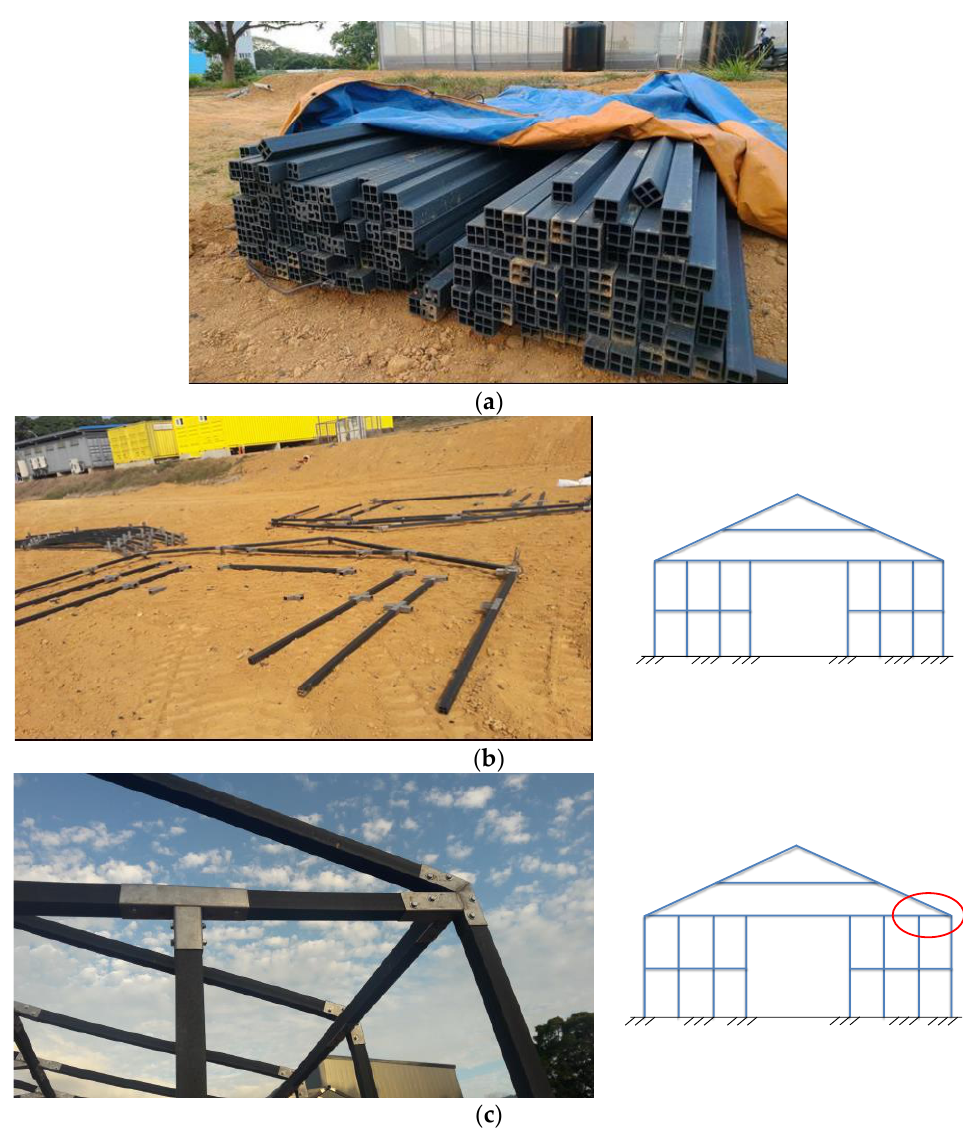
Figure 5. ( a ). Raw members delivered from the manufacturer. ( b ). Assembling process of the gable frames. ( c ). Joint fastener of the column, rafter, and joist. frames. ( c ). Joint fastener of the column, rafter, and